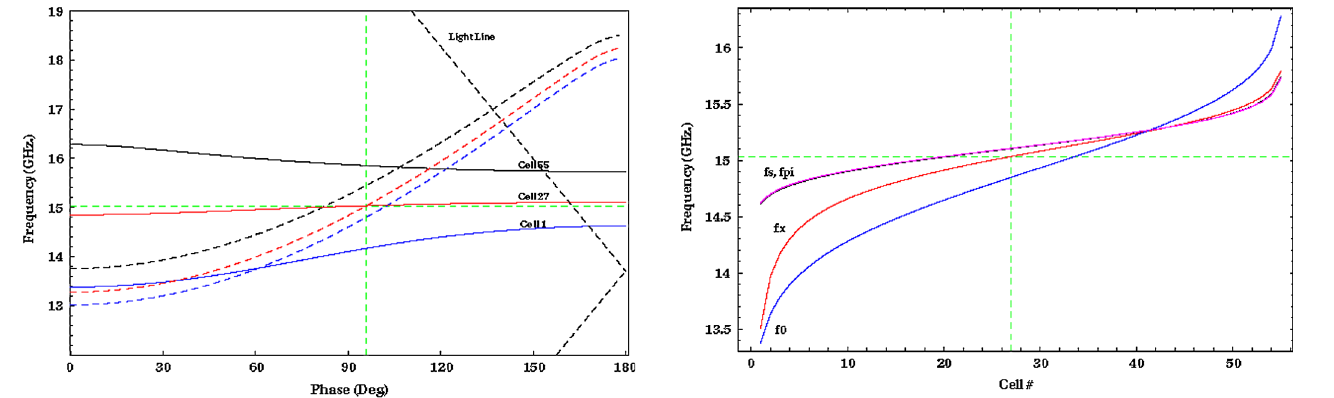
7. (Color) Brillouin diagram for the high phase advance accelerator